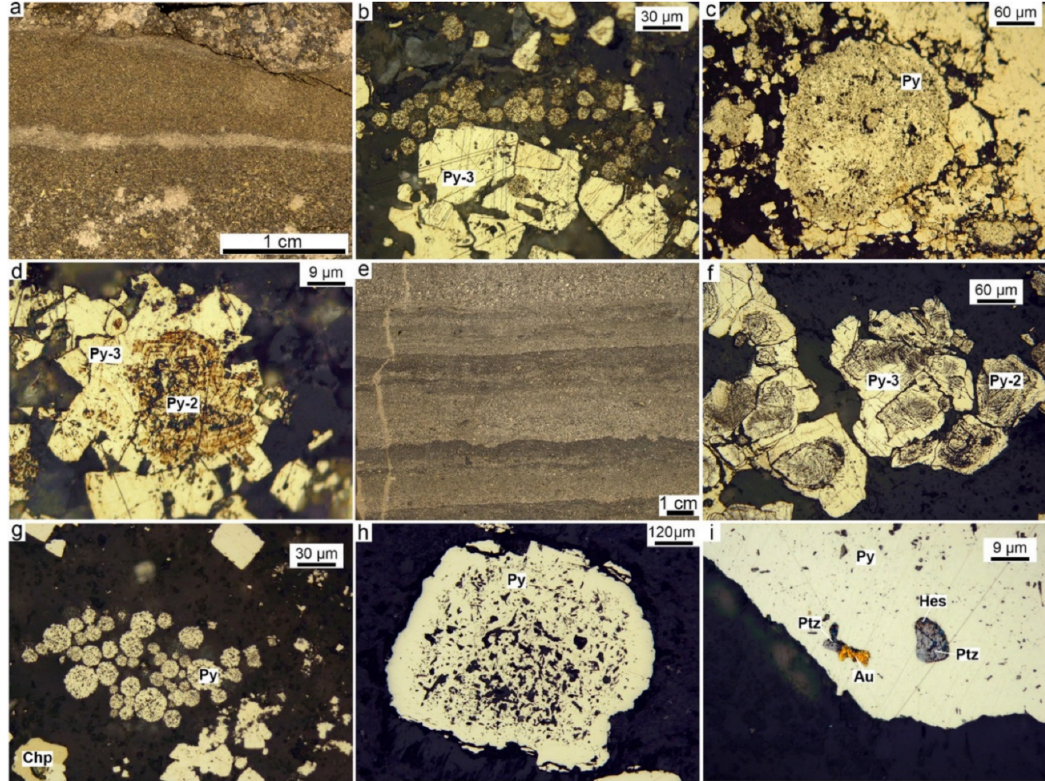
Figure 14. Mineralogical features of pyrite-rich diagenites of the Dergamysh ( a – d ) and Yubileynoe ( e – i ) deposits: ( a ) Pyrite-rich diagenites in sphalerite–pyrite turbidites; ( b , c ) nodules of framboidal ( b ) and fine-grained ( c ) pyrite; ( d ) relict zoned crystal of pyrite-2 with a rim of subhedral pyrite-3; ( e ) altered pyrite turbidites intercalated with hyaloclastic shales; ( f ) rims of pyrite-3 around zoned pyrite-2 fragments; ( g ) nodule of framboidal pyrite; ( h ) pyrite nodule; ( i ) hessite, petzite and native gold in a rim of pyrite nodule. ( a , e ) Polished sample; ( b – d , f – i ) reflected